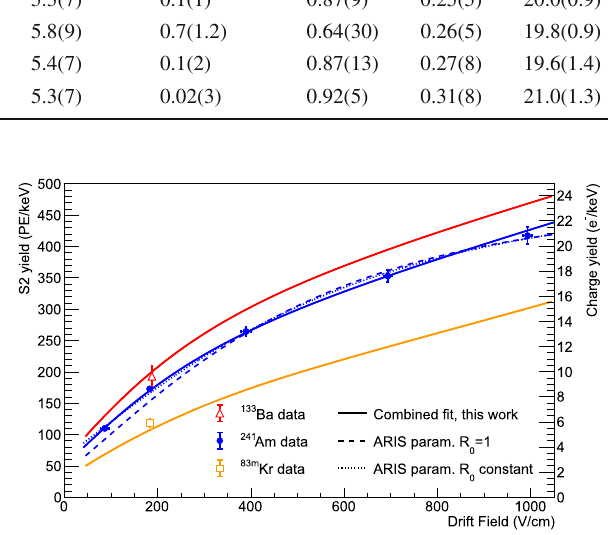
Fig. 18 S2 yield (left axis) and charge yield (right axis) vs. E d , from ReD double-phase measurements with 241 Am, 83 m Kr and 133 Ba sources. The solid lines correspond to the combined ‘ARIS + ReD’ model described in the text, with fit parameters given in Table 2, for 241 Am (blue), 133 Ba (red) and 83 m Kr (ochre). The dashed line shows thebestfittotherecombinationparameterisationemployedbytheARIS collaboration [41] ( D 1 = 0, R 0 = 1), while the dotted line lifts the con- straint R 0 = 1 of full recombination at null field. Data taken with 83 m